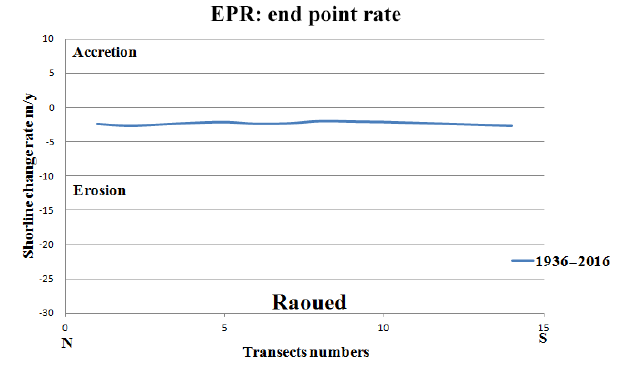
Figure 11. The rates of shoreline changes (EPR) in Raoued.